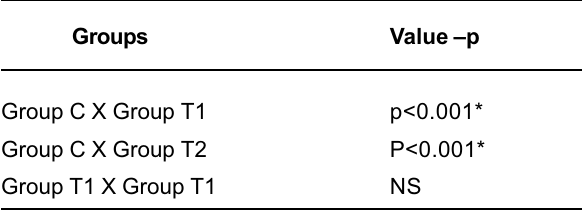
TABLE 3- Comparing among groups C, T1 and T2 regarding mentalis muscle contraction during